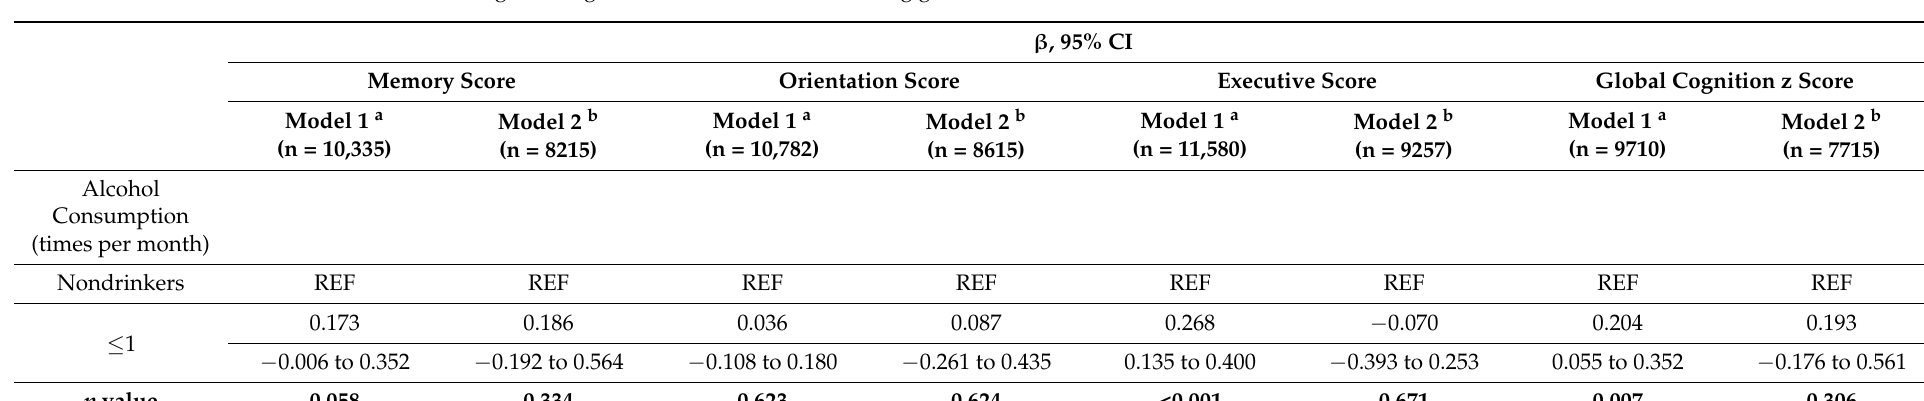
Table 2. Cross-sectional association between sleep duration per night (hours per month) for depressive symptoms, alcohol consumption (times per month), covariates, and global cognitive function at baseline using generalized linear